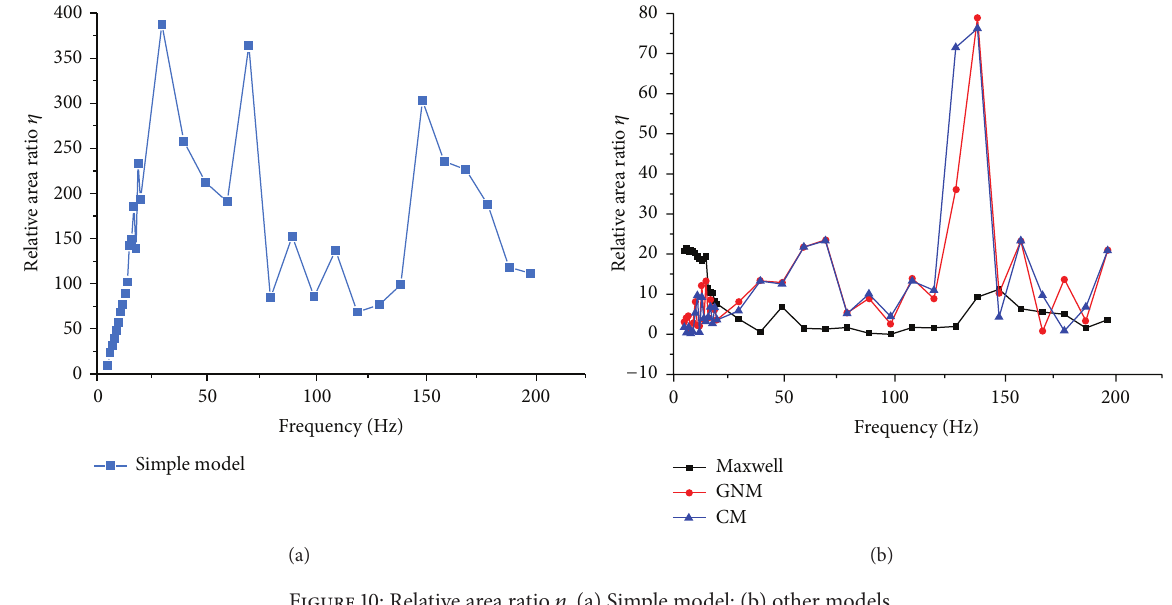
Figure 10: Relative area ratio 𝜂 . (a) Simple model; (b) other models.